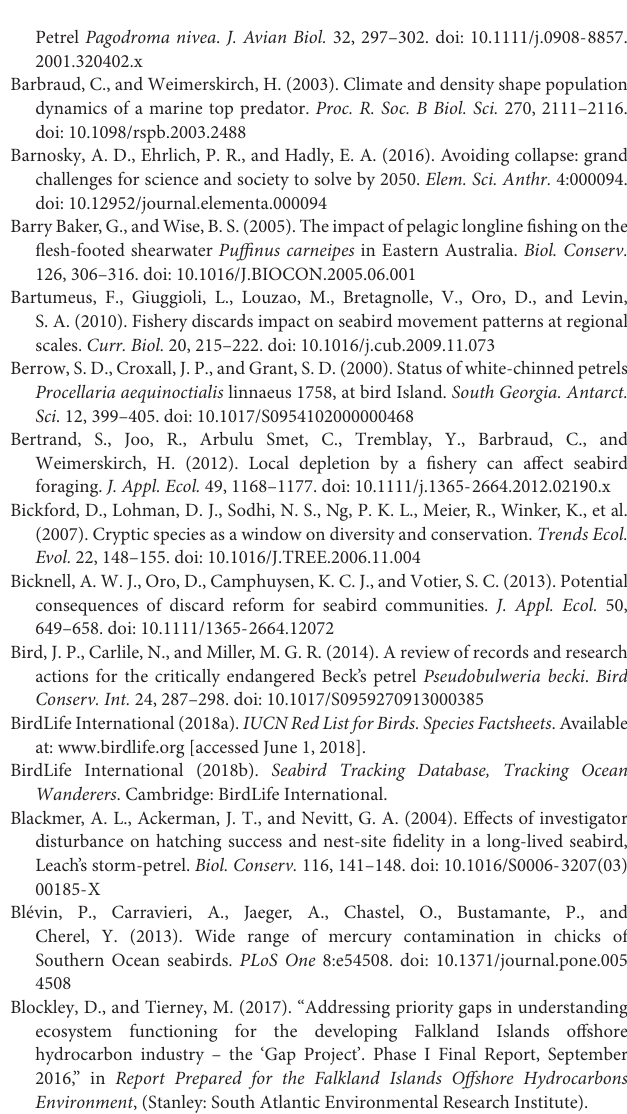
TABLE S1 | Reported effects of climatic environmental features on petrels and